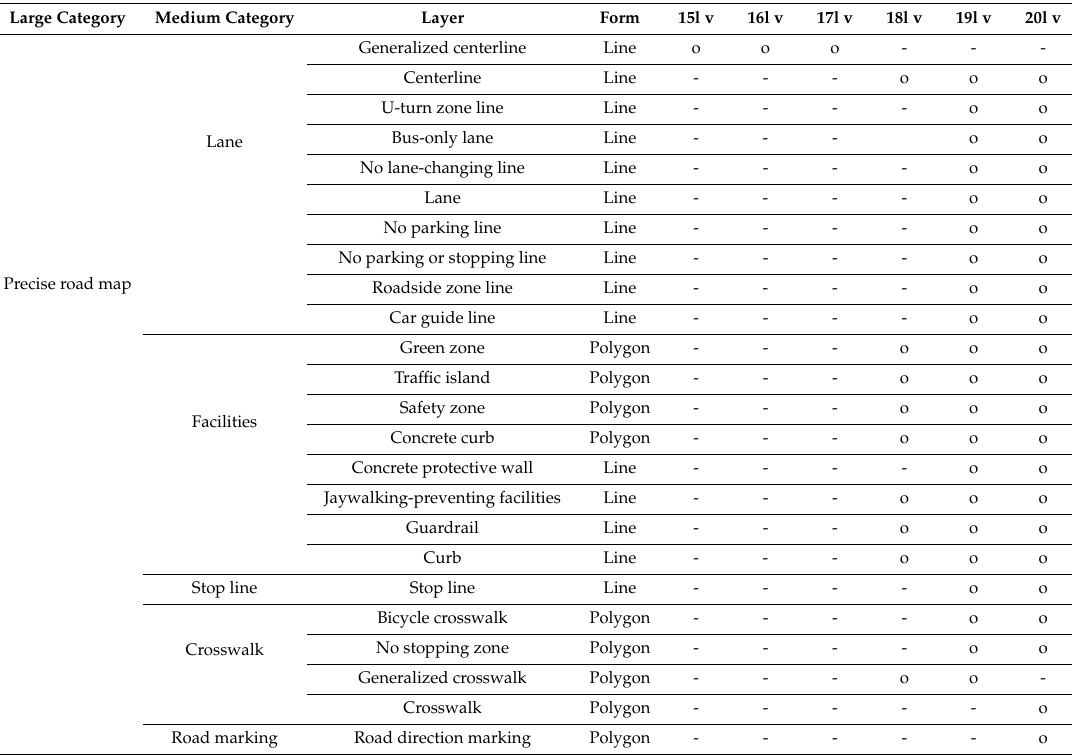
Table 5. Composition of the layers of a high-precision digital